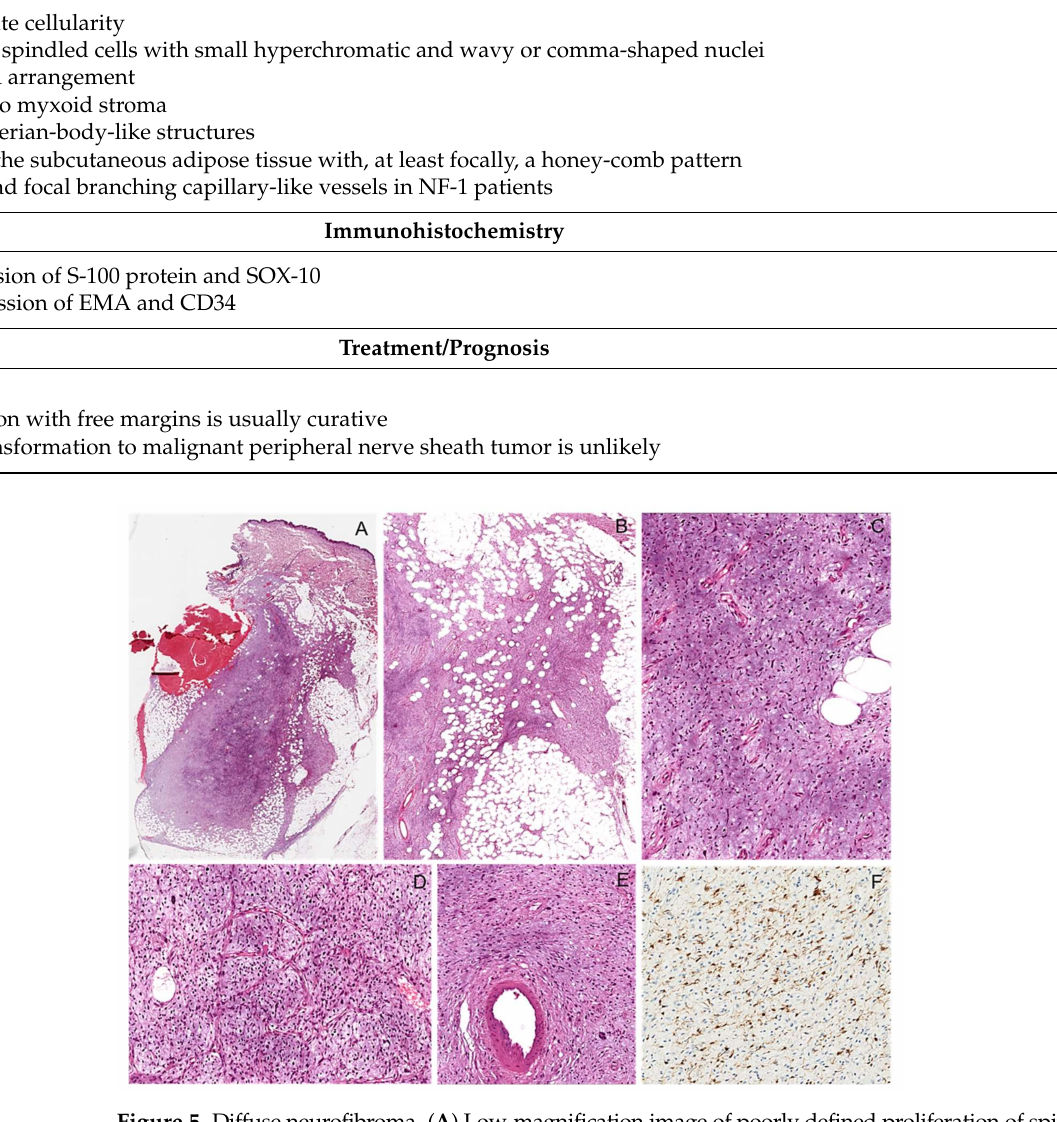
Figure 5. Diffuse neurofibroma. ( A ) Low-magnification image of poorly defined proliferation of spindle cells. ( B ) The neoplastic cells are infiltrating subcutaneous fat. ( C ) The neoplastic cells are embedded in an abundant myxoid stroma. ( D ) A rich plexiform vascular network is seen, mimicking a myxoid liposarcoma. ( E ) Neoplastic cells show focal nuclear atypia. ( F ) Neoplastic cells show cytoplasmic and nuclear staining for S100